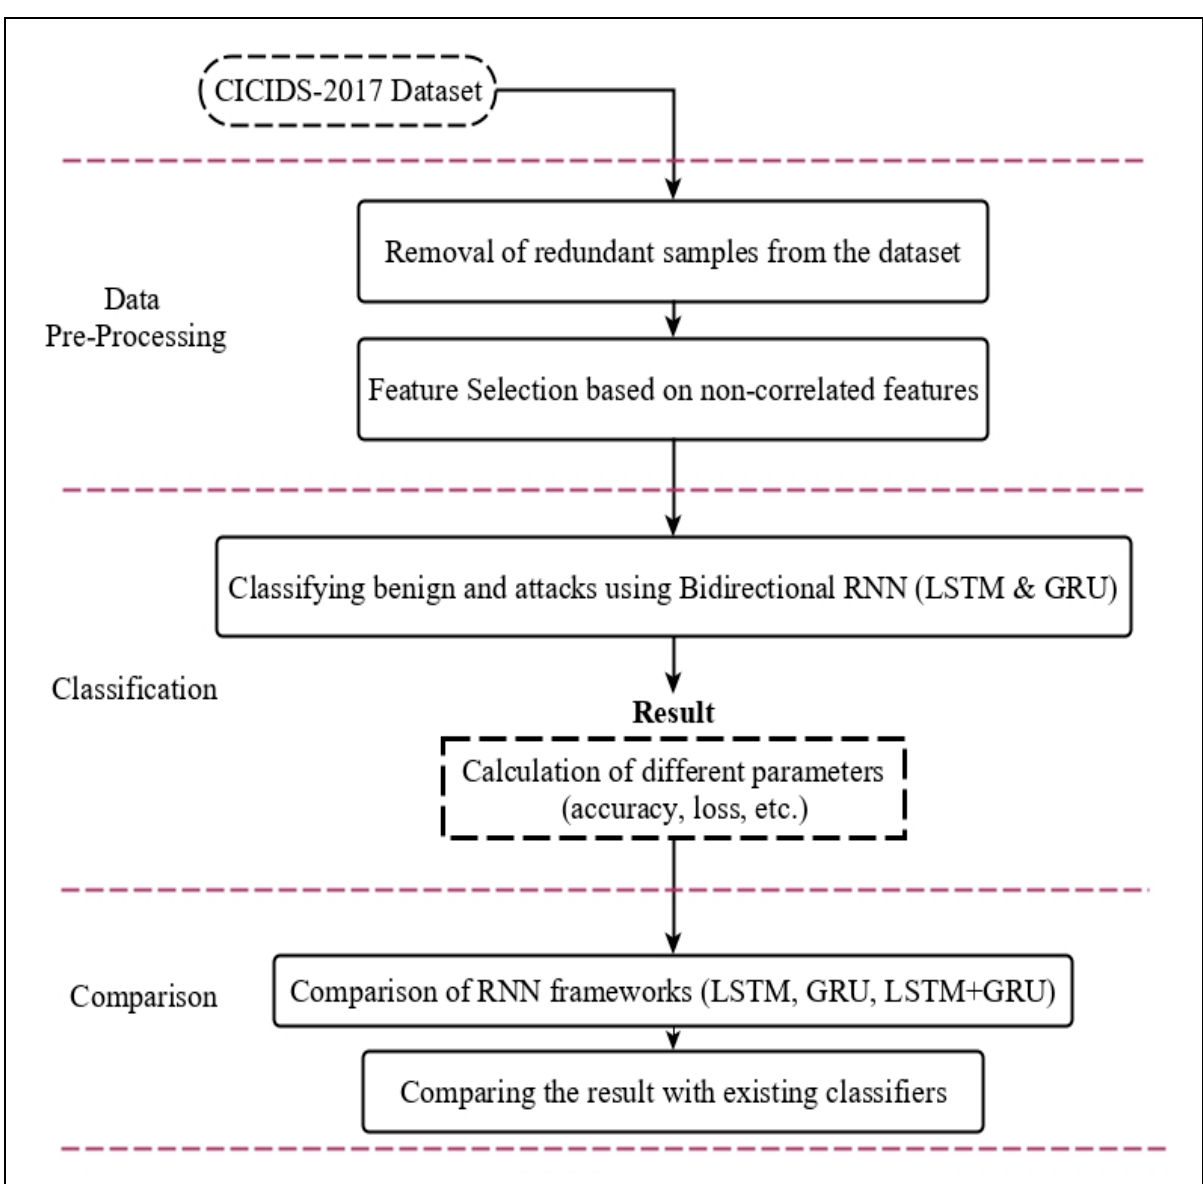
Figure 5. Proposed model layout.